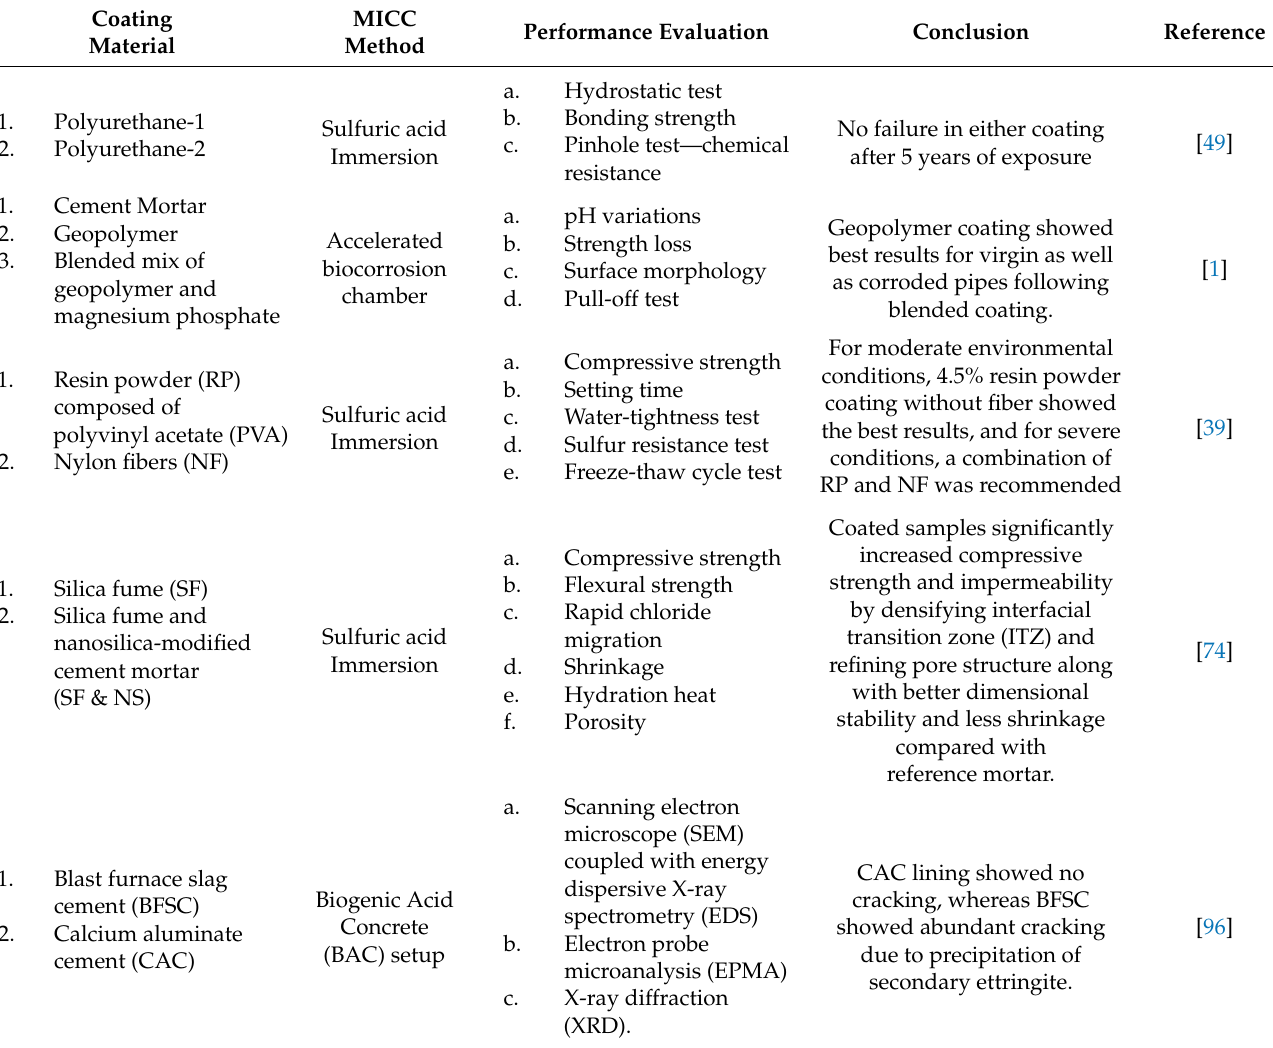
Table 3. Summary of the various coating materials used to reduce